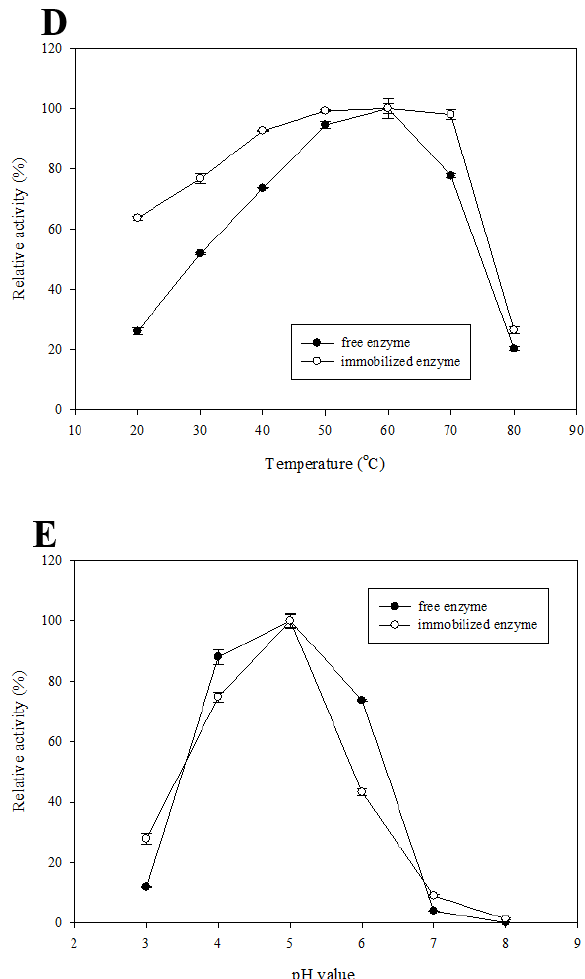
Figure 2. Immobilization conditions of β -glucosidase onto glass microspheres. The relative activity with glutaraldehyde concentration ( A ), the relative activity for activation time ( B ), and the relative activity for coupling time ( C ). The optimal reaction temperature ( D ) and pH value ( E ) on the relative activity of free and immobilized β -glucosidase. Each value is expressed as mean ± SD, and values marked by different letters were significantly different by LSD tests ( p < 0.05).